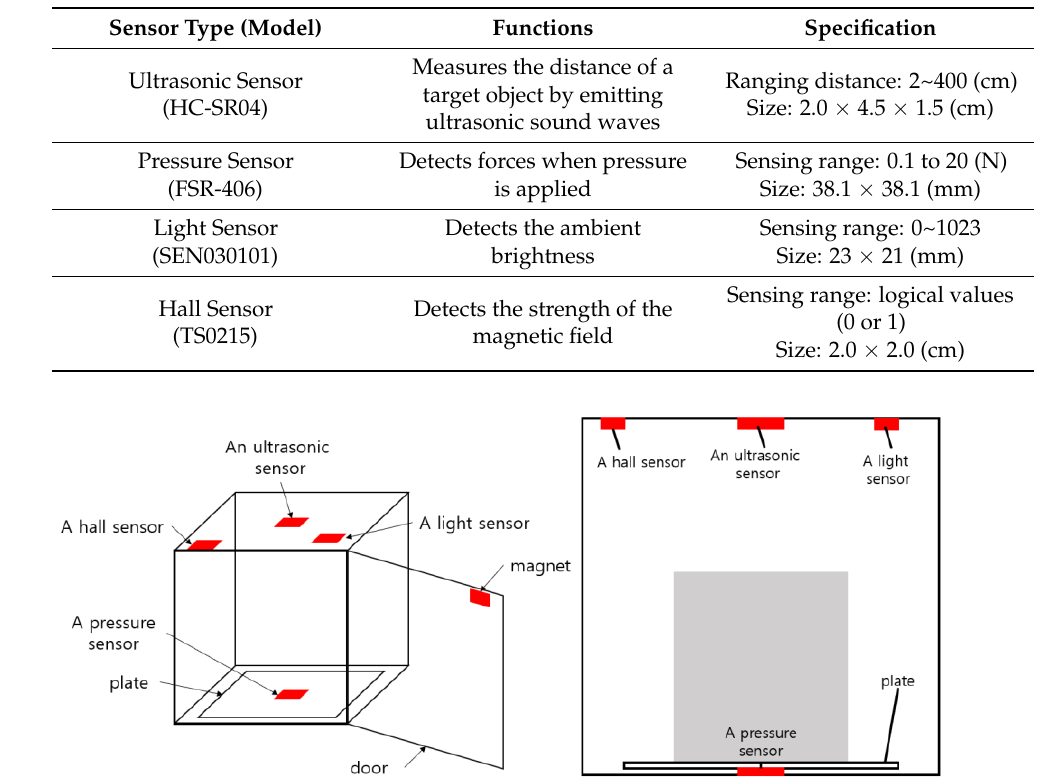
Table 1. The functions and specifications of the sensors used in the smart storage.